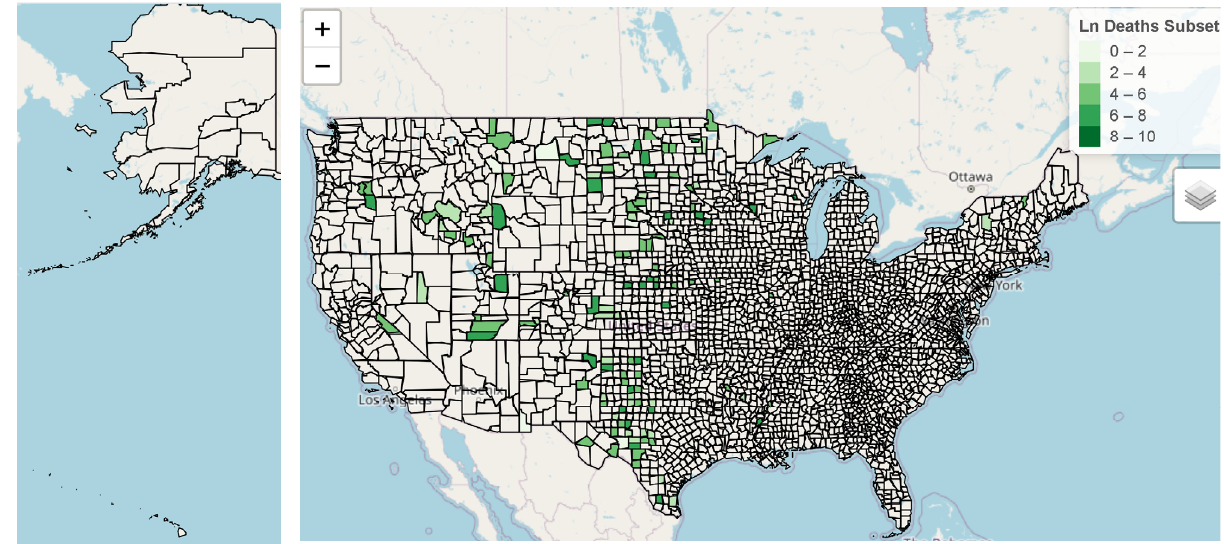
Figure 6. Logarithm of the Sum of COVID-19 Deaths (+1) for counties where the mean is greater than the variance (N = 137).